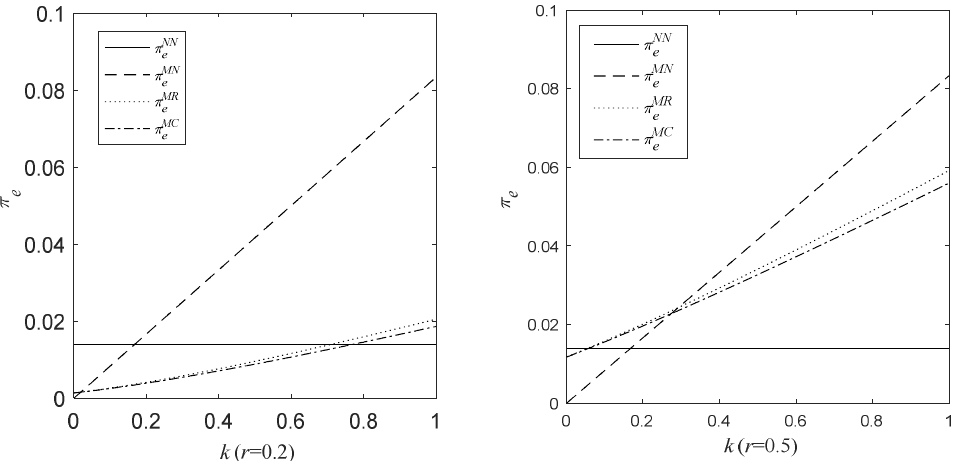
Figure 3. The impact on online retailers of the proportion of residual value after reduction of unit returned product value.